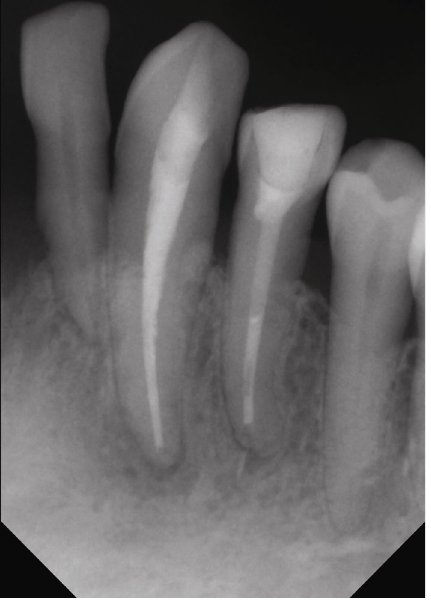
Figure 6: Postoperative periapical radiograph showing endodontic treatment of both teeth #33 and #34.